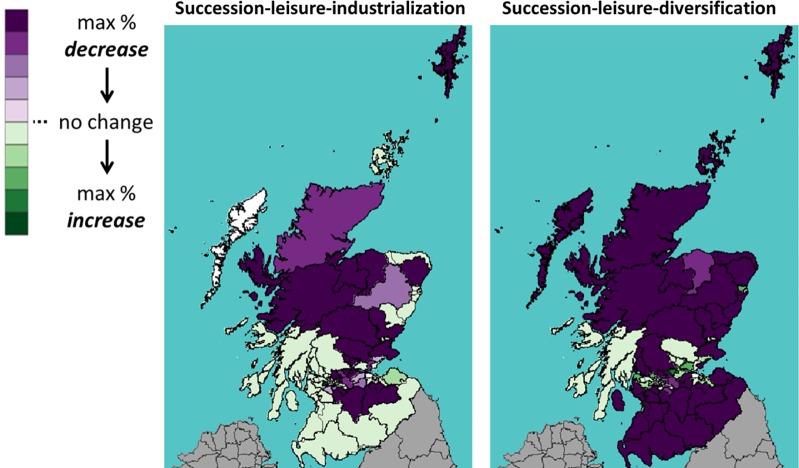
Percentage change in the number of dairy cattle under WTO scenario.